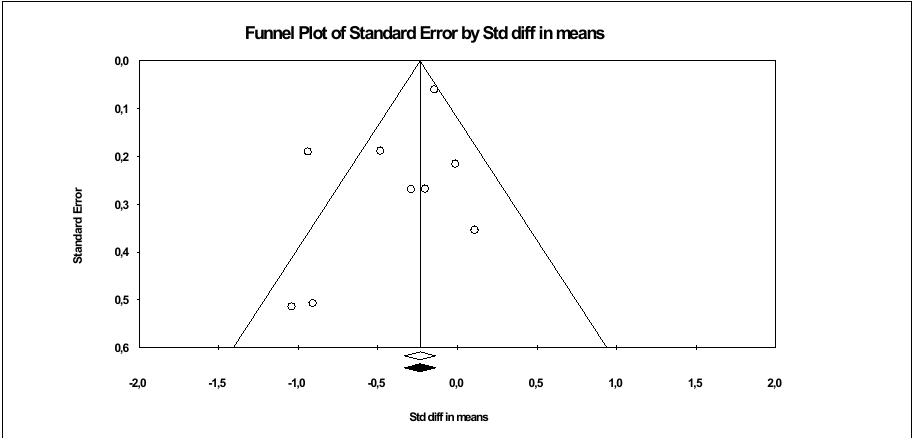
Figure 7 . Funnel plots assessing publication bias for depression symptoms. Figure 7. Funnel plots assessing publication bias for depression